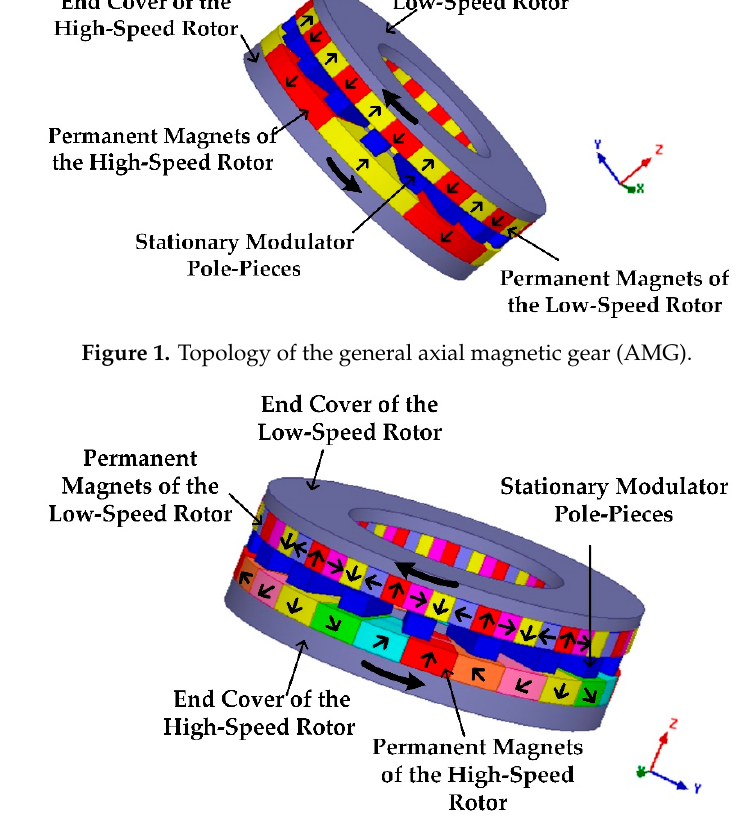
Figure 2. Topology of the axial magnetic gear with Halbach permanent magnet array (HAMG). Table 1. Key parameters of the HAMG.